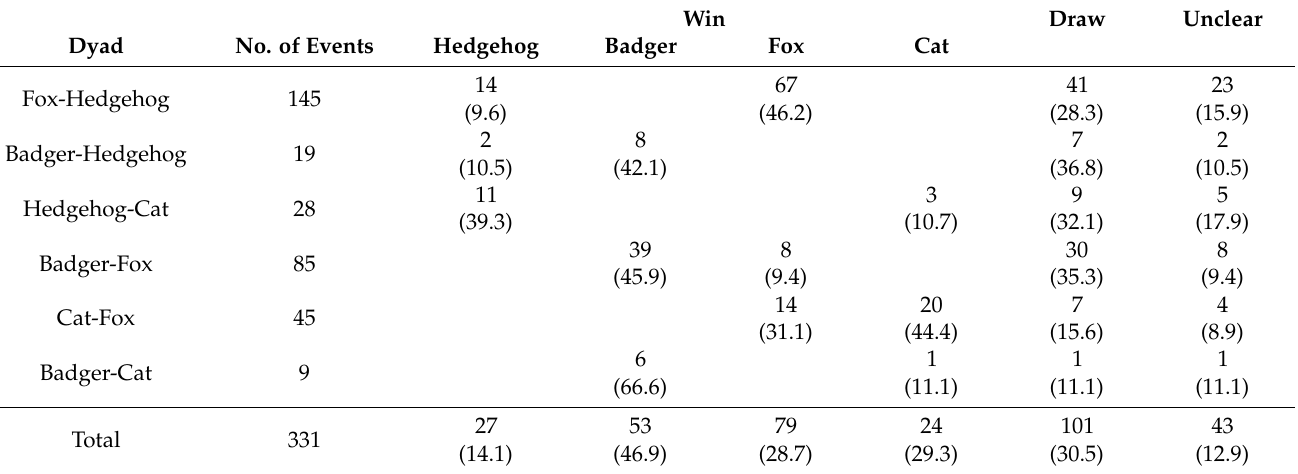
Table 4. The number of events recorded from videos sent in by volunteers between each dyad of four species of urban mammal (Western European Hedgehog ( Erinaceus europaeus ), Eurasian badger ( Meles meles ), Red fox ( Vulpes vulpes ), and domestic cat ( Felis catus )), and the number and relative percentage (%) of ‘wins’ for each species within the